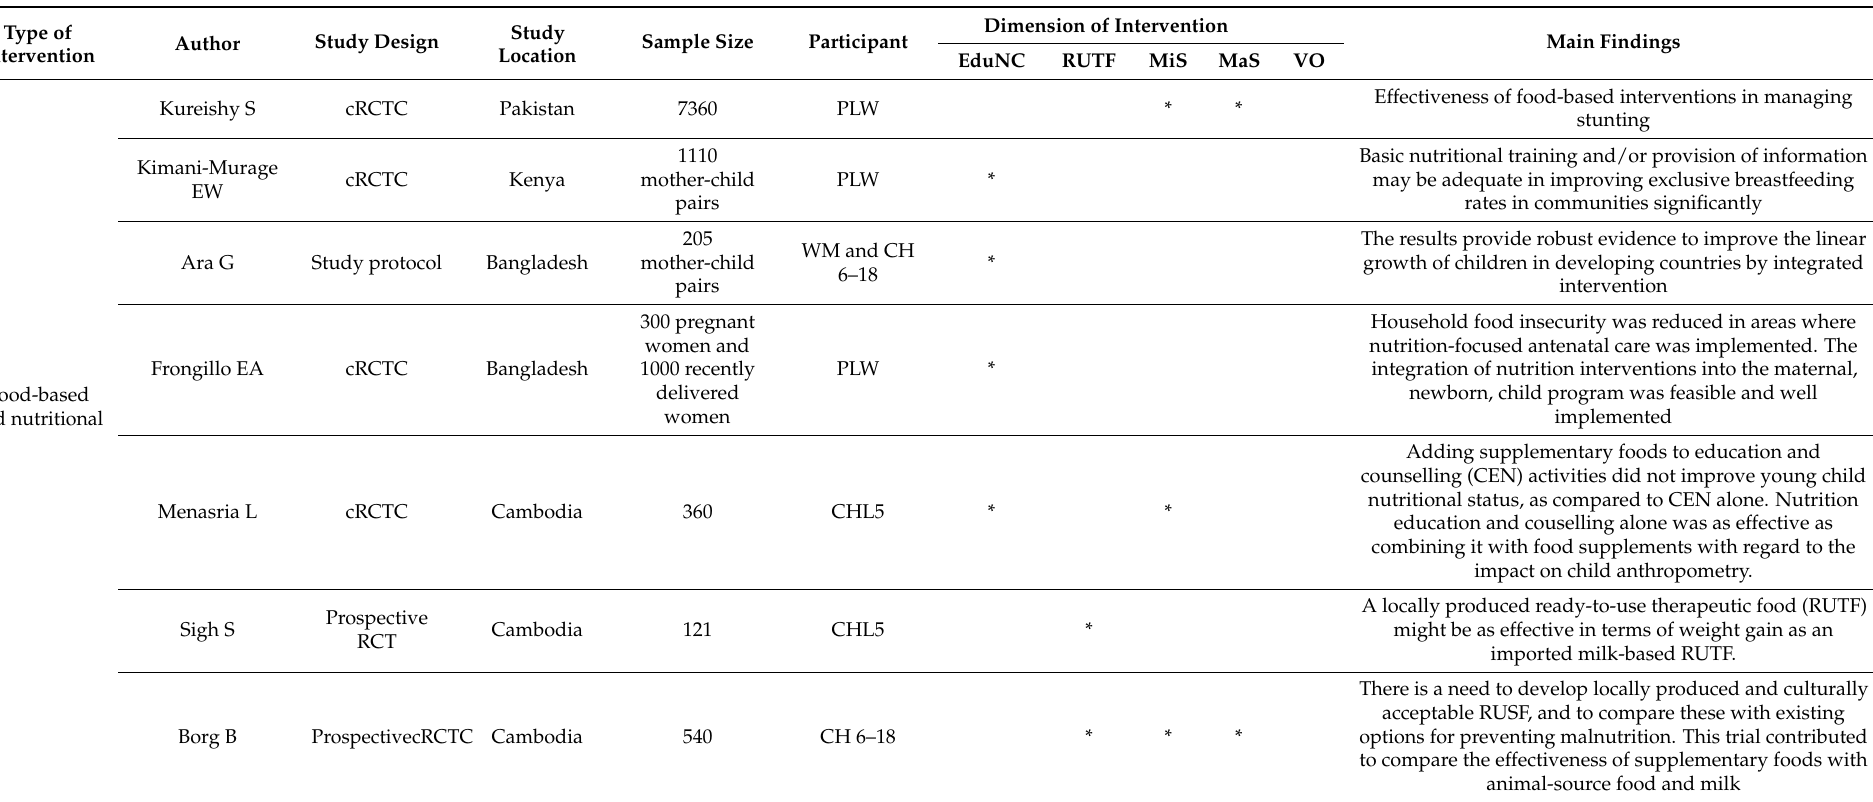
Table 2. Summary of general characteristics of selected articles, featured by type of intervention and classified considering the dimension approach and type of participant ( PLW : Pregnant and lactating women; WM : Women mothers; CH 6 : Children < 6 months; CH 6–18 : Children 6–18 months; CH 18 : Children > 18 months; CHL5 : Children < 5 years; CHW : Community health workers; WRA : Women of reproductive age) in the intervention. Study design: cRCTC—Cluster Randomized Controlled Trial; RCT—Randomized Controlled Trial. The dimension of intervention has been marked with the symbol * (EduNC: Education and Nutrition Counselling; RUTF: Ready to Use Therapeutic Food; MiS: Micronutrient Supplement; MaS: Macronutrient Supplement and VO: